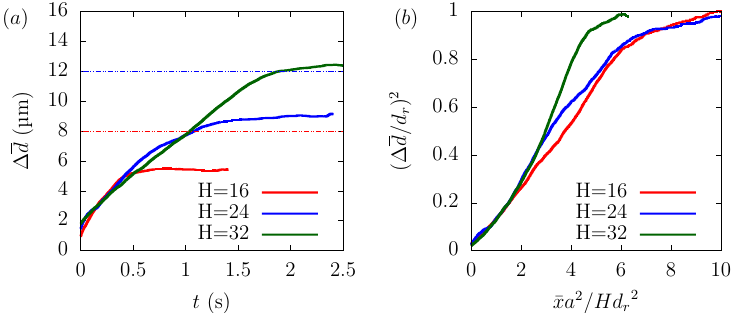
Figure 7. Dependency of particle margination on channel size H in H = 16 µ m, 24 µ m, and 32 µ m. ( a ) Time history of ∆ d and ( b ) ∆ d normalized by half the channel height H and x normalized by a 2 / Hd r 2 .